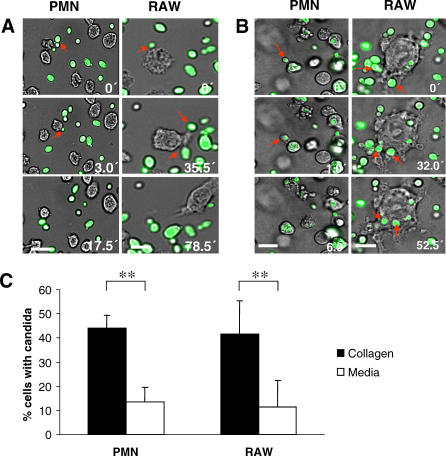
Phagocytosis of C. albicans by PMN and RAW Cells Is Enhanced in 3-D Environments(A) Image sequences from videos with PMN and RAW cells interacting with C. albicans in a 2-D system. Bar = 25 μm. The images show several contacts between the cells and the fungus (red arrows) without any ingestion or dragging.(B) Time series showing efficient uptake of C. albicans (red arrows) by PMN and RAW macrophages. Image sequences from videos with PMN and RAW cells interacting with C. albicans in a 3-D collagen matrix. Bar = 25 μm. Interactions were observed over a period of 3 h.(C) Quantitative representation of the effect of the environment on the phagocytosis of C. albicans by PMN and RAW cells in 2-D and in 3-D environments. The number of cells that had internalized C. albicans cells was counted 30 min after the start of imaging. The data represent the average percentage of cells internalizing yeasts from three independent experiments, representing a total of 241 PMNs in collagen, 187 in media, and 141 RAW macrophages in collagen, 97 in media. **, p < 0.01. Error bars represent SD.